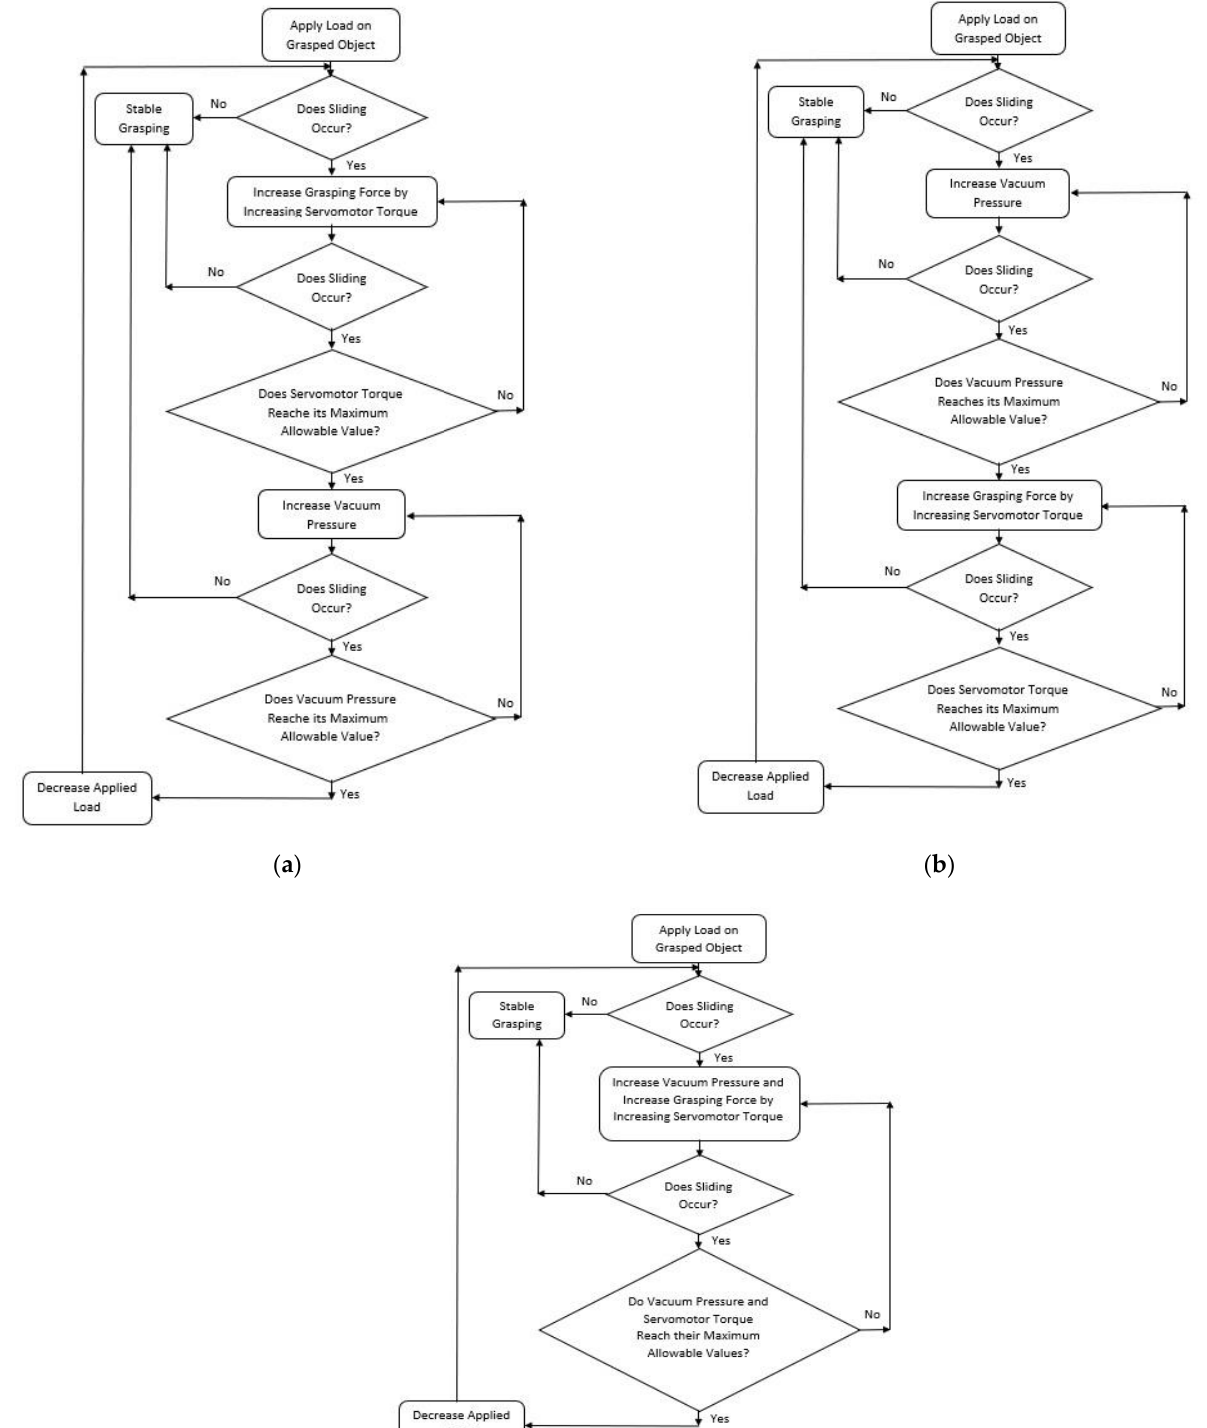
Figure 3. Flowcharts of the three control procedures. ( a ) The servomotor was activated by the feedback signal. ( b ) The vacuum pump was first activated according to the feedback signal. ( c ) The servomotor and the vacuum pump were concurrently activated after receiving the feedback signal from the controller.